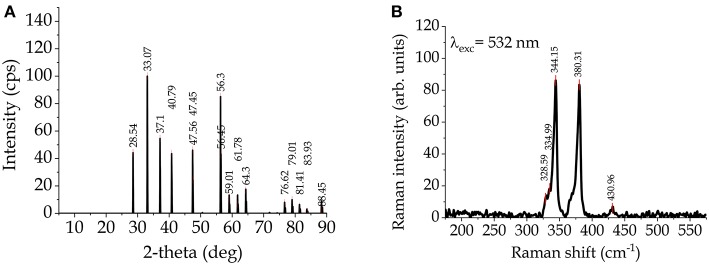
(A) XRD pattern and (B) Raman spectrum of FeS2.